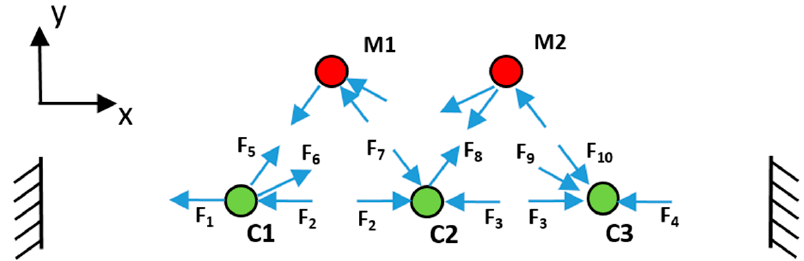
Figure 4. Elastic forces resulting from the measured points and node displacements.